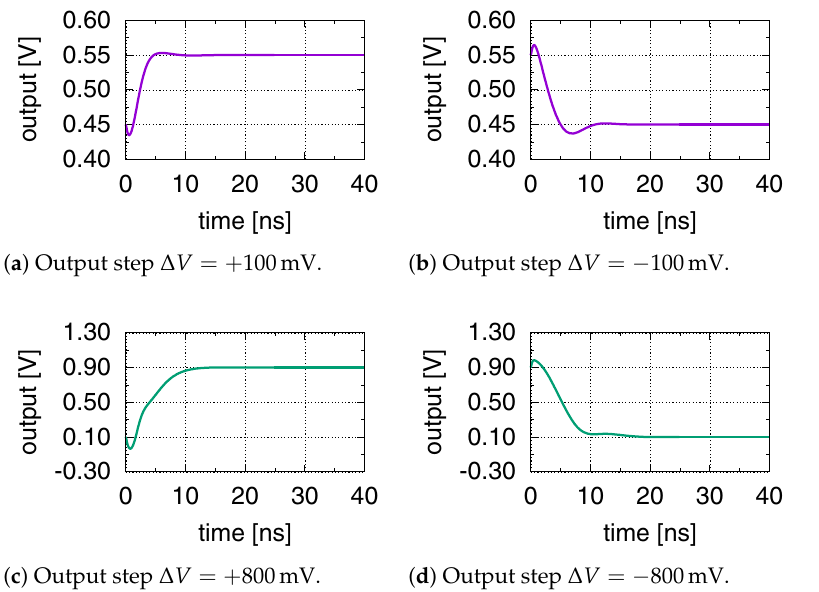
Figure 12. Bode diagram of the open-loop gain of the circuit in Figure 9. Figure 14 shows the plot of the 0.5% settling time versus the step amplitude at the output node. The curve of the single-pole case, evaluated from (22), is also reported. As expected, for the rising edge, the settling time remains well below the single-pole limit up to 0.9 V. Above this value, some transistors enter the triode region, and the settling time goes out specifications. The falling output step suffers from slew-rate limitation at the output node. This is mitigated by the SR enhancer that allows the settling time to follow the single-pole limit up to 0.9 V, also in this case.